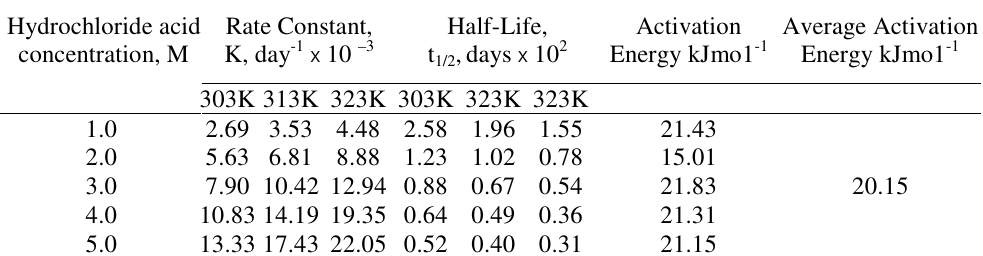
Table 1. Kinetic data for mild steel in different concentrations of hydrochloric acid solution without additives (Inhibitor).